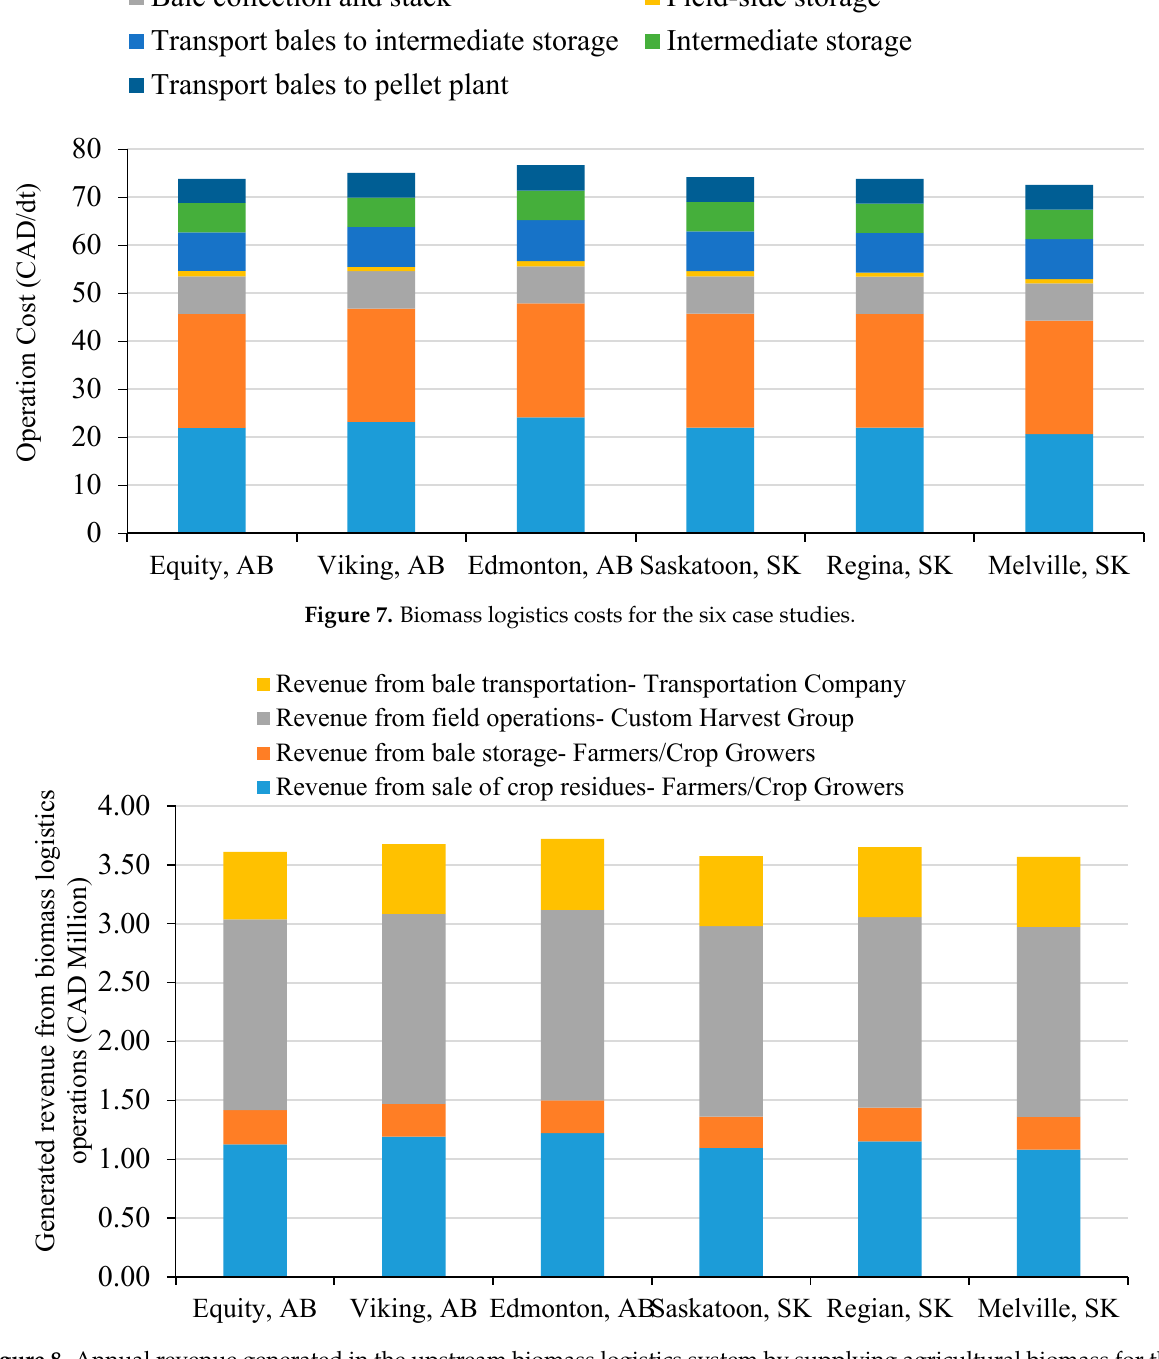
Figure 9. Contribution of different biomass logistics operations to the total annual generated incomes in all six case studies (in Canadian dollars).